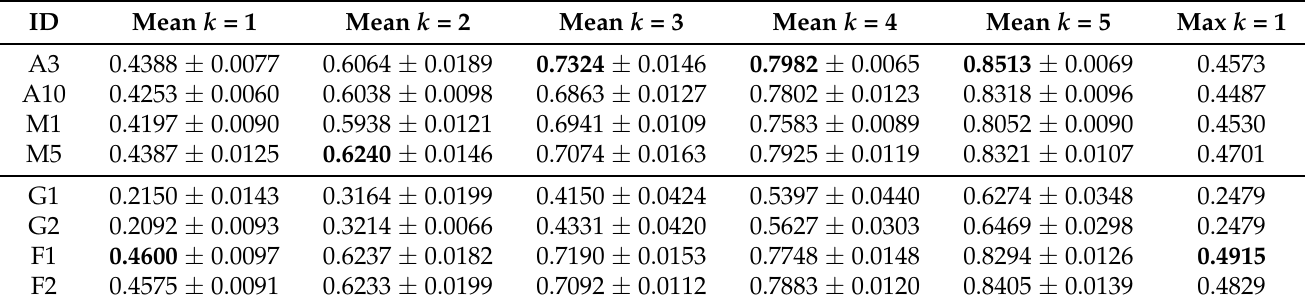
Table 2. Architecture experiments. Accuracy at k . Mean accuracy and standard deviation for 100 executions. Maximum accuracy at 1 is also reported. ID is the architecture